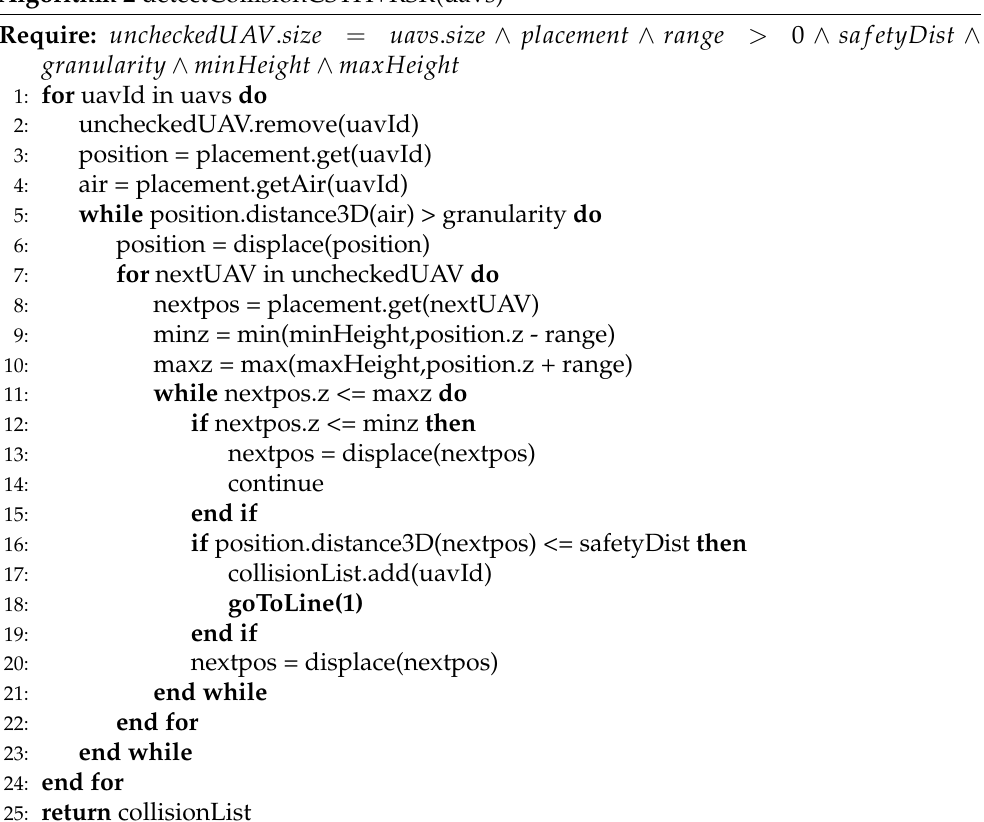
Figure 6. Overview of the CSTH+RSR approach. Algorithm 2